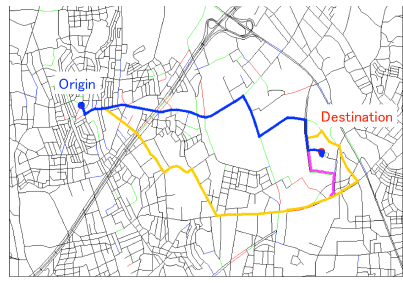
Figure 11. Routes generated by the proposed method in Chiba